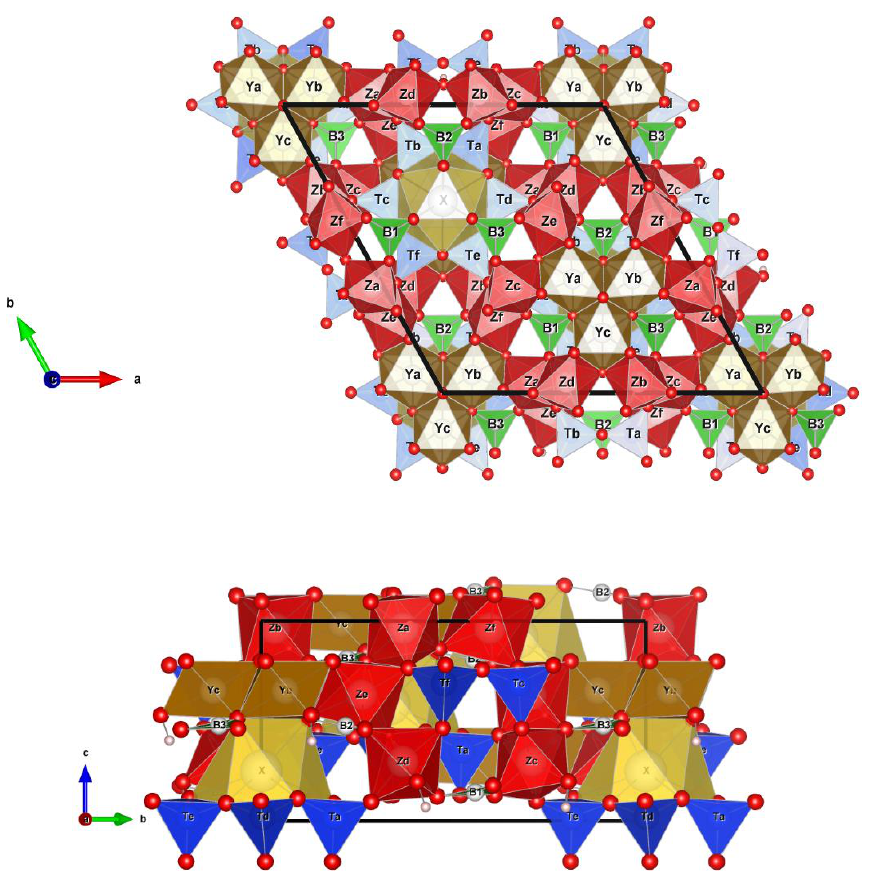
Figure 4. Triclinic tourmaline structure showing the pseudohexagonal R 1 unit-cell [ a = 15.9513(5), b = 15.9421(5), c = 7.1921(2) Å, α = 90.0354(17) ◦ , β = 89.9359(16) ◦ and γ = 119.8527(14) ◦ ] similar to the typical hexagonal triple R cell. Note that the arrangement of polyhedra is the same as that of the trigonal structure. Structure obtained with Vesta 3 [18].